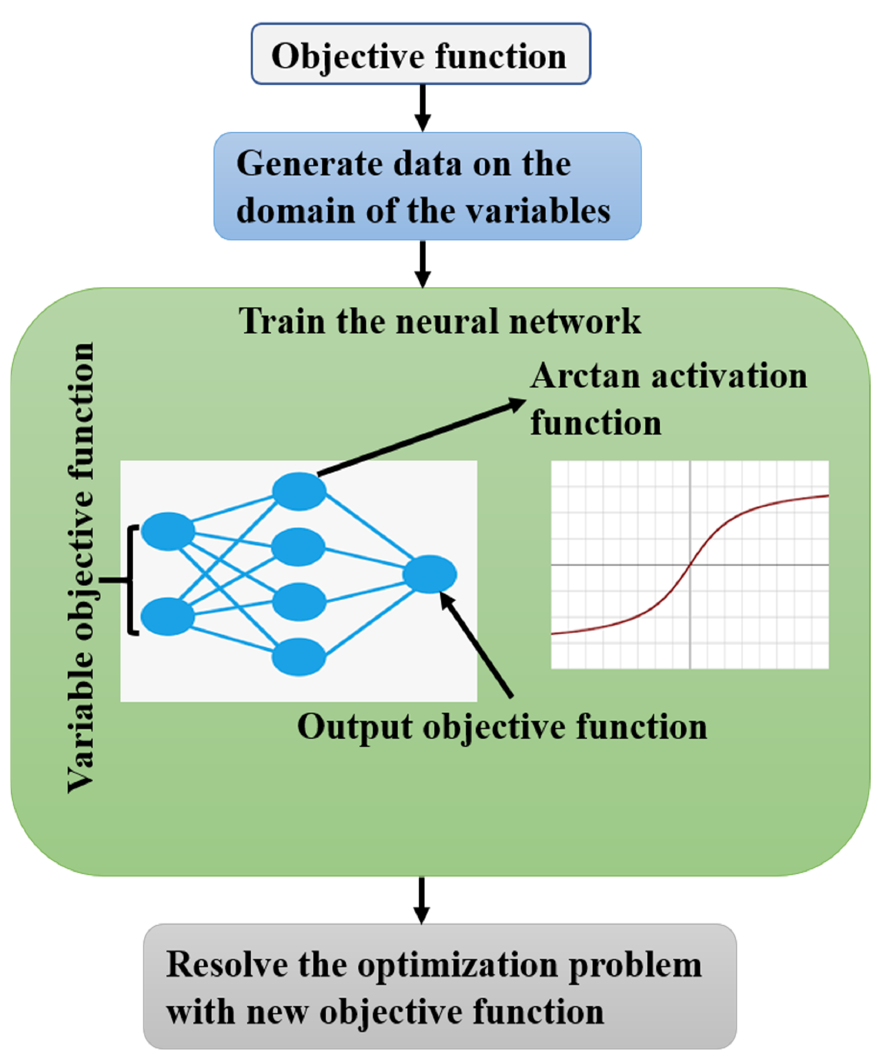
Figure 11. Generic framework to solve an optimization problem in estimations of BEB energy con- sumption based on ANN model. consumption based on ANN